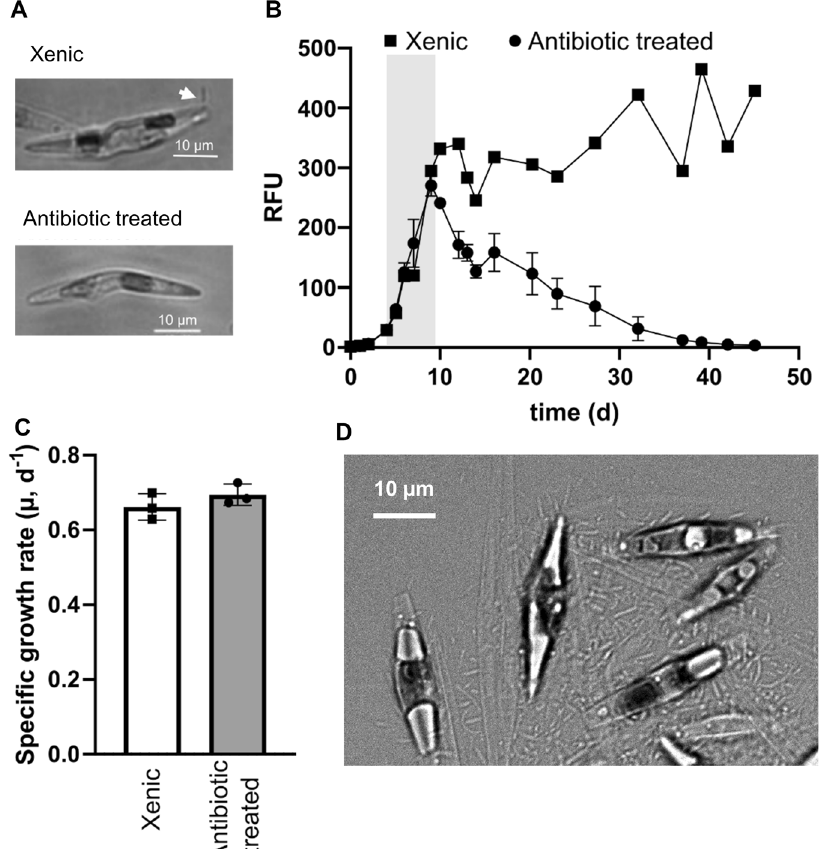
Fig. 3 Co-isolated bacterial community promotes stationary phase survival for P. subcurvata grown in nutrient replete conditions. A DIC microscopy images of P. subcurvata cells from xenic cultures (top) or after treatment with antibiotic cocktail (bottom). Arrow indicates bacterial epibiont. B Relative Fluorescence Units (RFU) as a proxy for diatom growth over time for xenic (squares) and antibiotic-treated (circles) P. subcurvata culture grown under nutrient-replete conditions. Gray shading indicates time points (days 4 – 9) used to calculate growth rates in C . C Growth rates of P. subcurvata calculated during exponential phase growth. Error bars are the standard deviation of 3 biological replicates. D DIC microscopy image of xenic P. subcurvata cells covered with epibionts after growth in nutrient-replete conditions for ~90